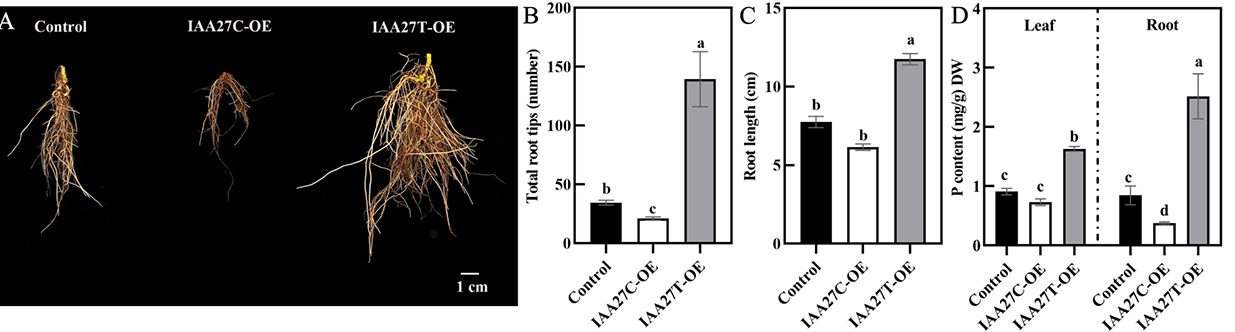
Figure 6. Effect of MdIAA27 on phosphorus tolerance in transgenic apple plants. ( A ) The phenotypes and P content of 75-day-old transgenic and control apple plants treated with low phosphorus (LP, 10 μM KH 2 PO 4 ) for 10 days. Transgenic plants were grown for 14 days with P and then transferred to a hydroponic solution lacking P for 10 days. ( B , C ) Statistical analysis of total root tips and root lengths. ( D ) Phosphorus content of transgenic and control lines after treatment with LP (10 μM KH 2 PO 4 ) for 10 days. Error bars indicate standard deviations (s.d.) from three biological replicates. Different letters represent significant differences ( p < 0.05).